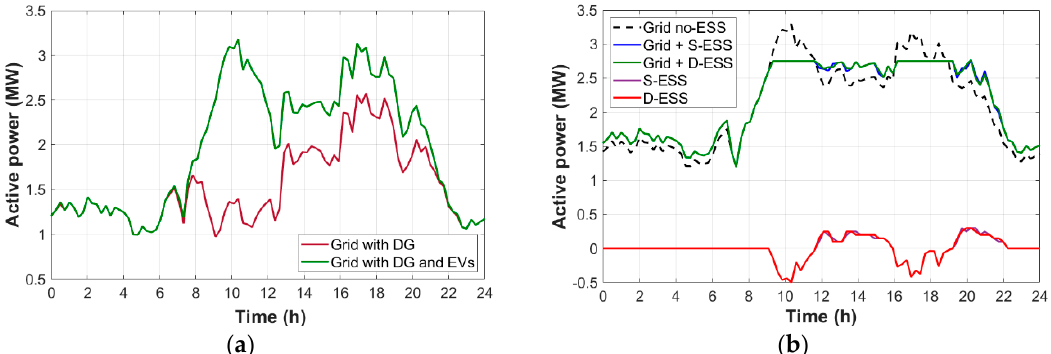
Figure 8. ( a ) Active power drown from the UniSA microgrid by adding the EVs charging load; ( b ) Daily trends of active power drawn by the UniSA campus from the external grid with CSs using dedicated ESSs (D-ESS) and shared ESSs (S-ESS).